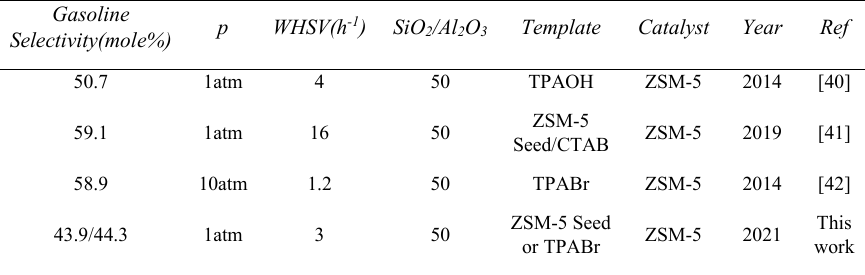
Table. 7. Comparison results with other literature in MTG Table 7. Comparison results with other literature in